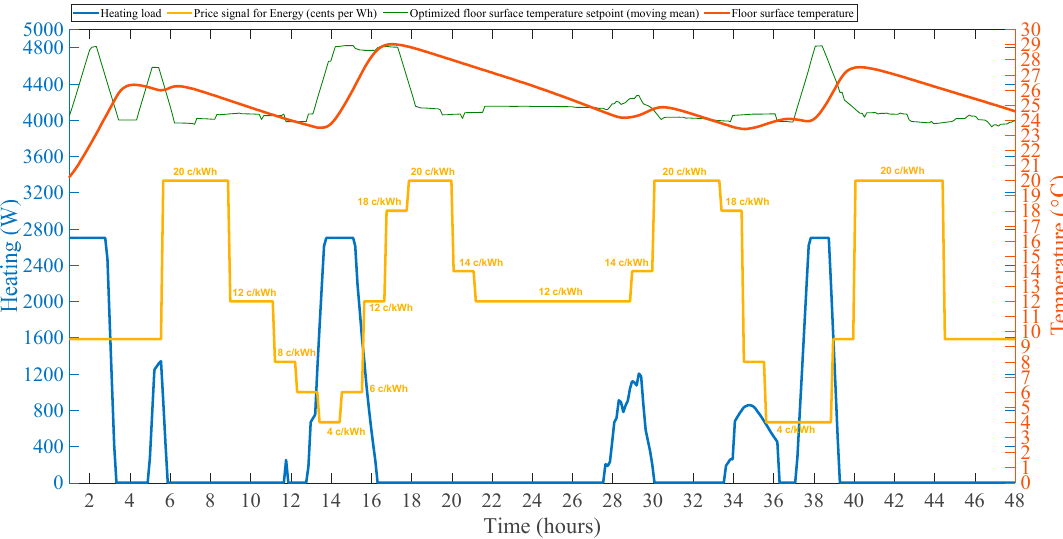
Figure 19. Predictive strategy for dynamic energy price signal.